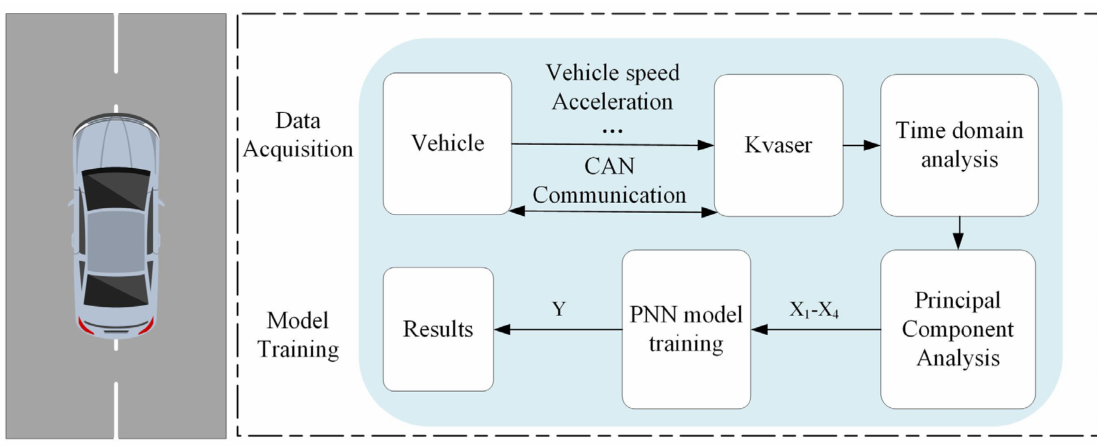
Figure 1. Model training workflow